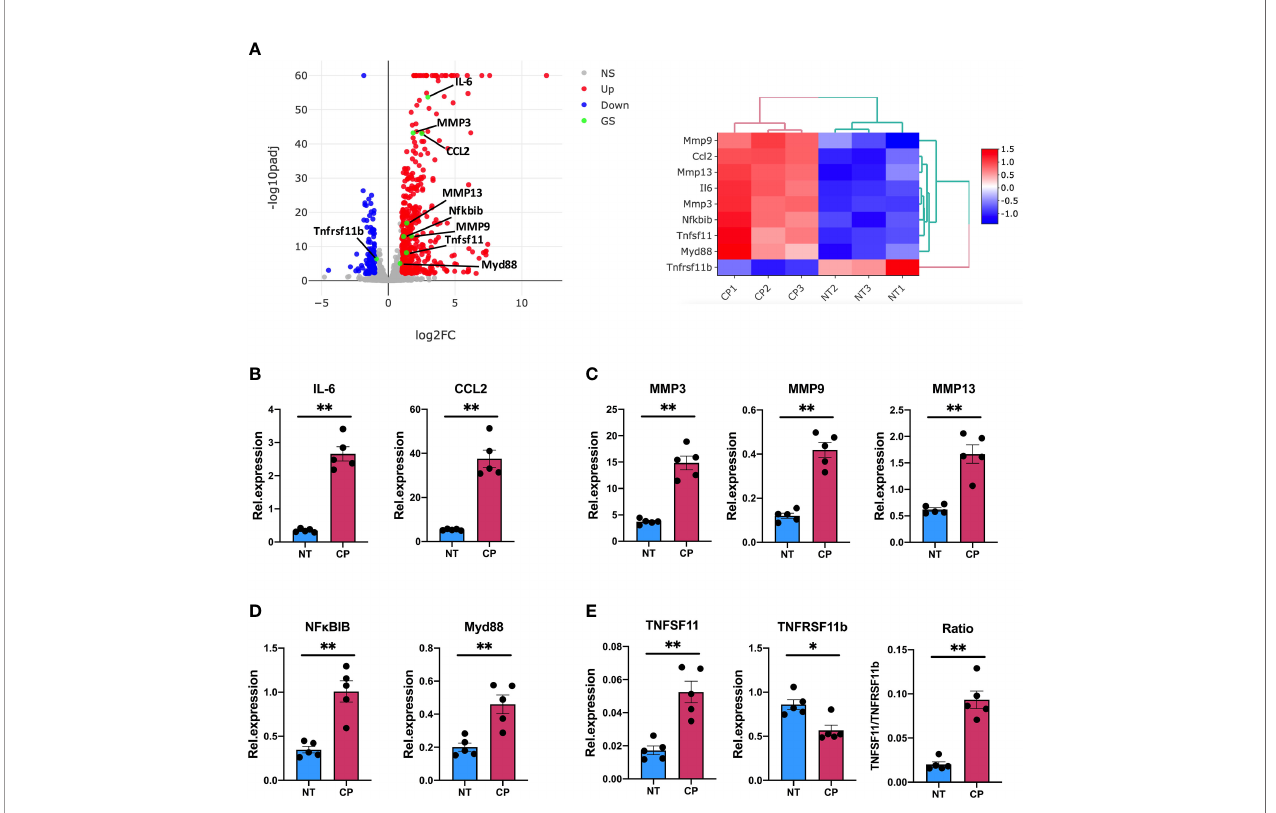
FIGURE 5 | Sialidase-treated synovial fi broblasts show an enhanced in fl ammatory response. (A) mRNA expression as detected by RNA-Seq from Figure 3 for MMP3, MMP9, MMP13, IL-6, CCL2, Myd88, Nf k bib, Tnfsf11 and Tnfrsf11b. (B – E) RNA was isolated from control (NT) and C. perfringens sialidase treated (CP) naïve SFs. Relative expression of the genes shown in (A) was assessed by RT-qPCR using the DD Ct method and actin as housekeeping gene. (B) IL-6 and CCL2, (C) MMP3, MMP9 and MMP13, (D) Myd88 and Nf k bib, and (E) Tnfsf11 and Tnfrsf11b. For (B – E) , each dot represents one independent experiment, error bars represent SEM (n = 5), *p < 0.05, **p < 0.01 evaluated by Mann-Whitney test. NS, non-signi fi